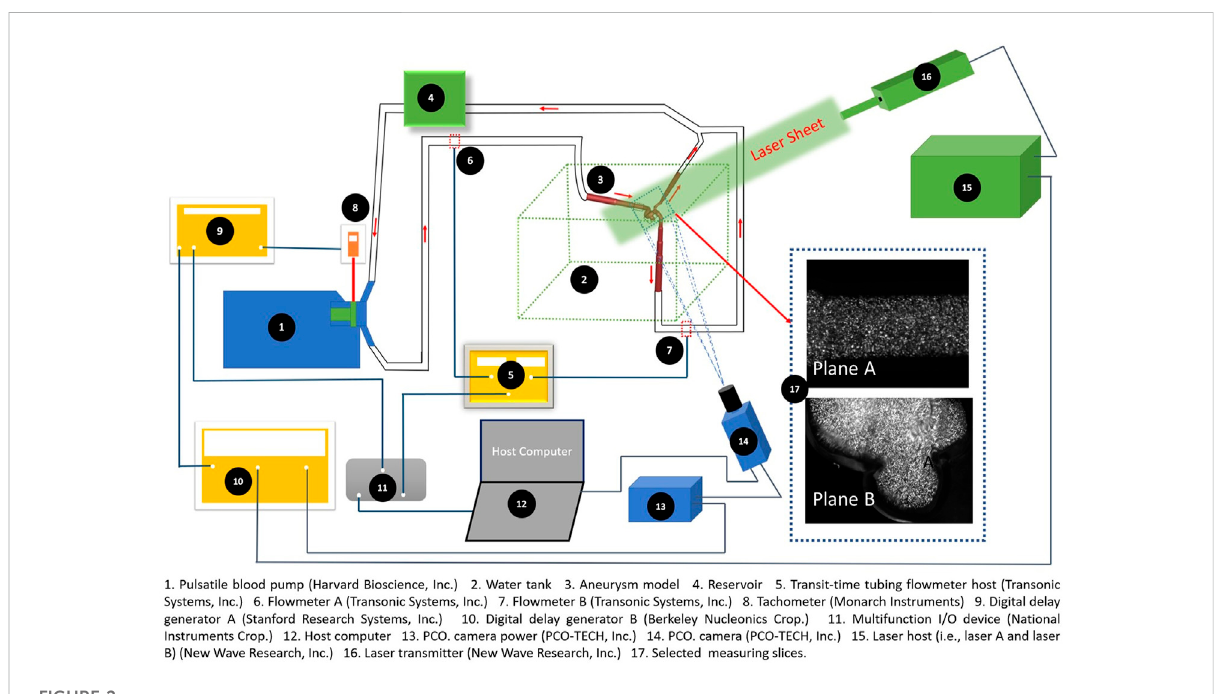
FIGURE 2 Experimental setup for PIV